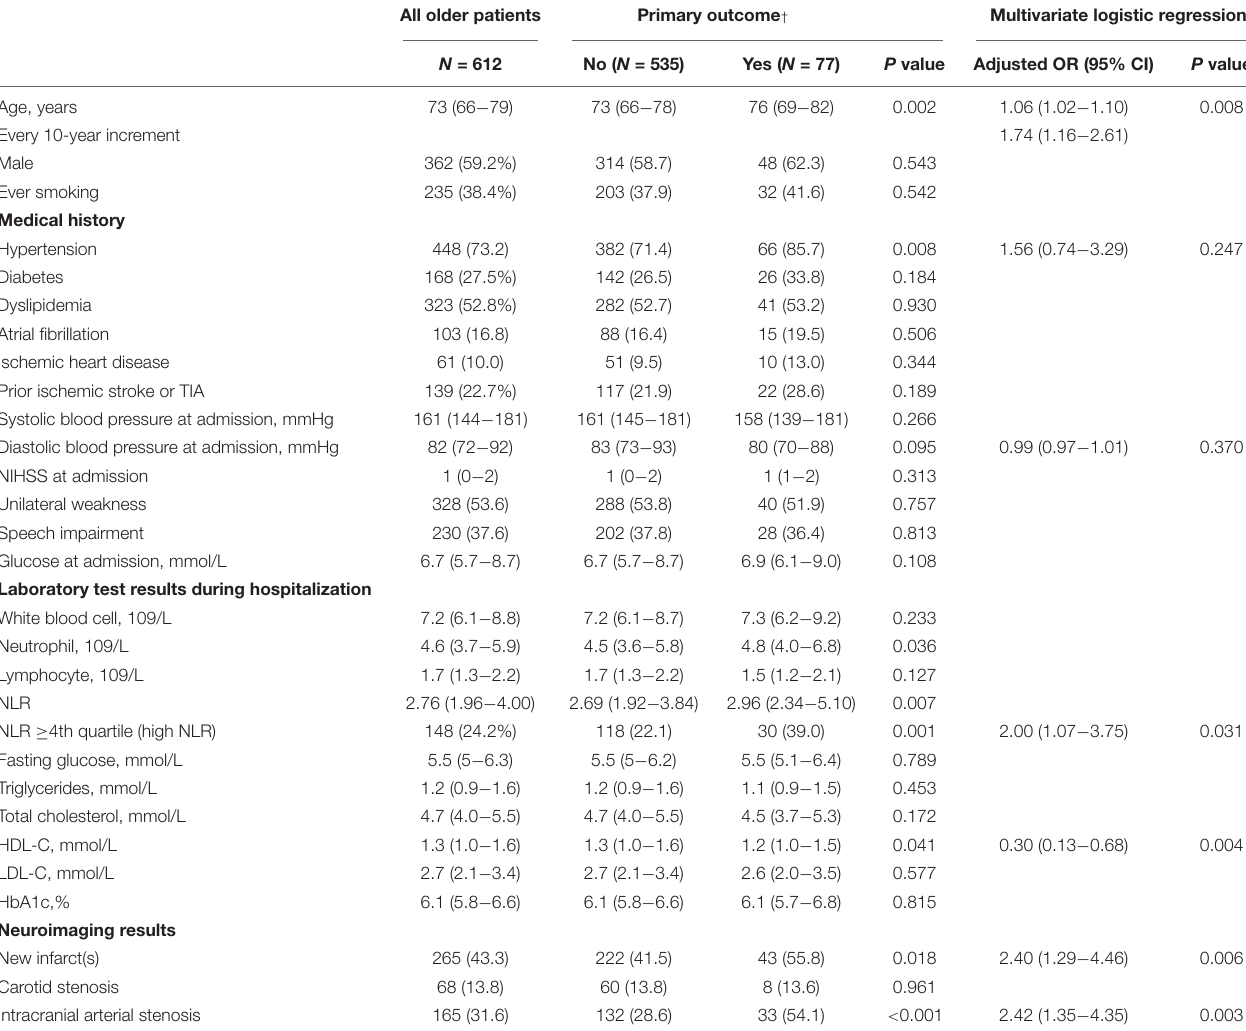
TABLE 3 | Predictors of the primary outcome among older patients (aged ≥ 60 years) *. All older patients Primary outcome † Multivariate logistic